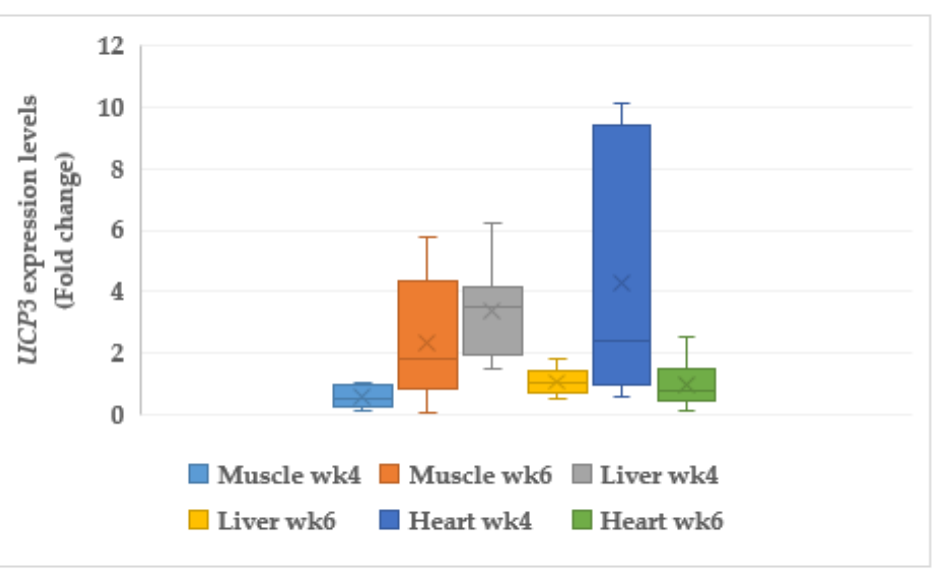
Figure 2. Expression profiles of mitochondrial uncoupling protein 3 ( UCP3 ) in the muscle, liver, and heart at week 4 and 6 in corticosterone-fed chickens (fold-change). wk4 = 4 weeks of age (2 weeks of CORT administration); wk6 = 6 weeks of age (4 weeks of CORT administration); n = 20.